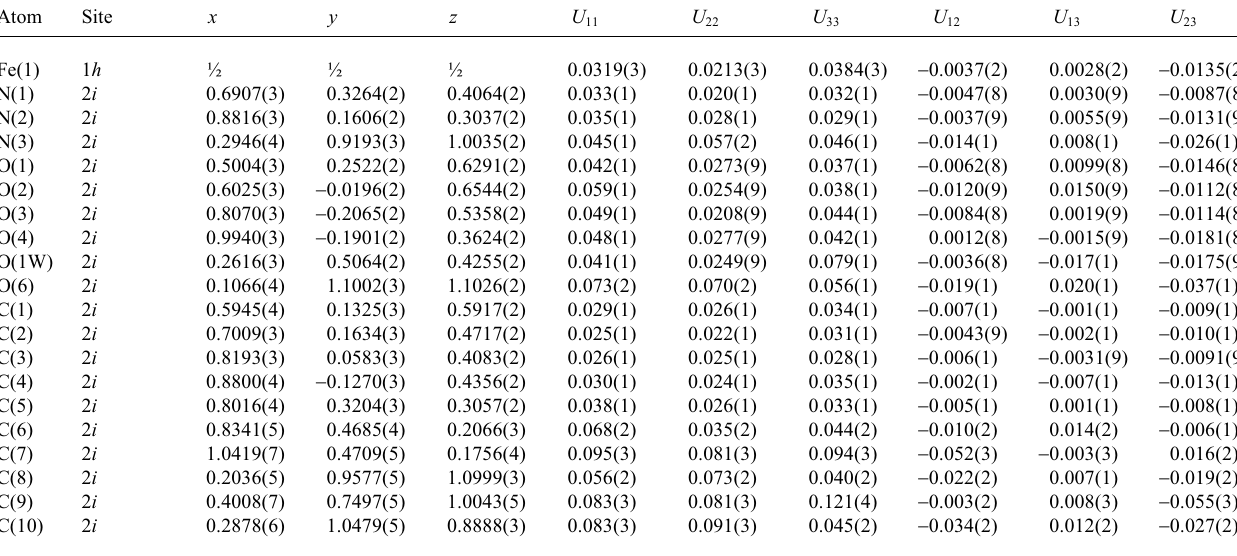
Table 3. Atomic coordinates and displacement parameters (in Å 2